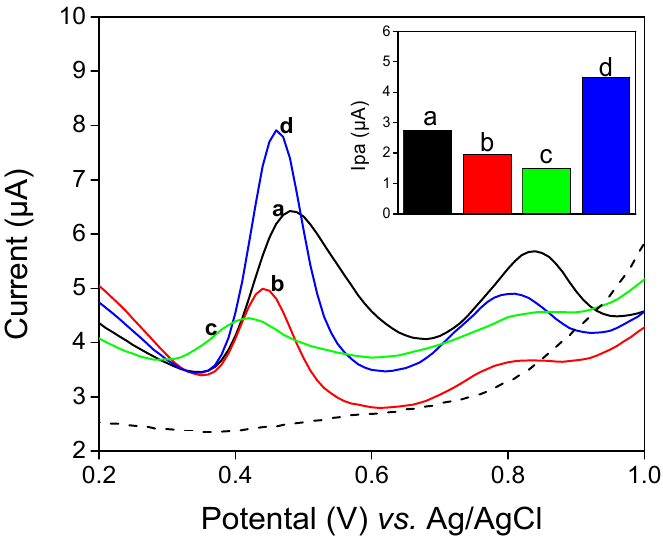
Figure 5. Differential pulse voltammograms (DPV) for 10 − 4 M of quercetin (QCT) in (v/v) phosphate buffer and EtOH mixture solution (pH 2) in ( a ) LaNH 2 /GCE, ( b ) La/GCE, ( c ) GCE and ( d ) LaNH 3 + /GCE working electrodes.